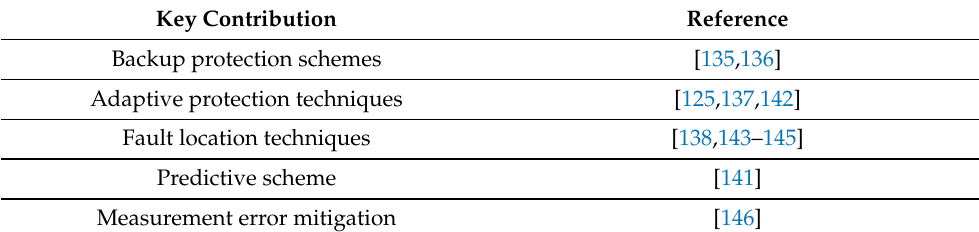
Table 10. Summary of